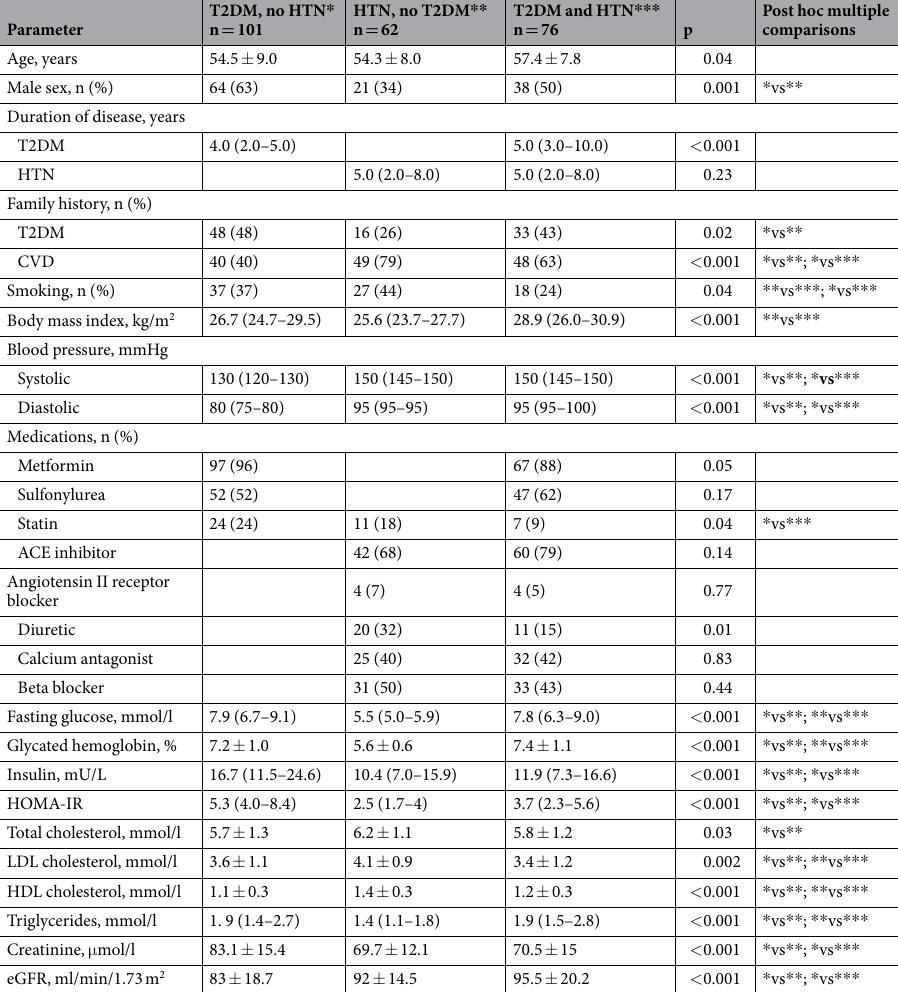
Table 1. Baseline characeristics and laboratory data. ANOVA; Data is presented as means ± SD, median [25–75th percentile], or percentages; T2DM-type 2 diabetes, HTN-hypertension, CVD-cardiovascular diseases; HOMA-IR-homeostatic model assessment of insulin resistance index, HDL-high density lipoprotein, LDL-low density lipoprotein, eGFR-estimated glomerular filtration